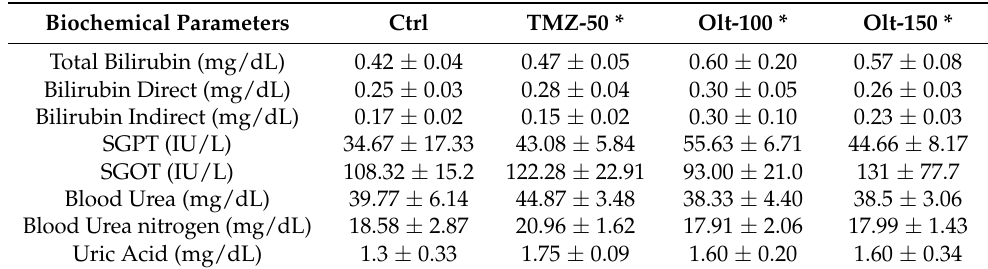
Table 3. Assessment of serum biochemical parameters in tumor-bearing mice administered with the Olt for 21 days